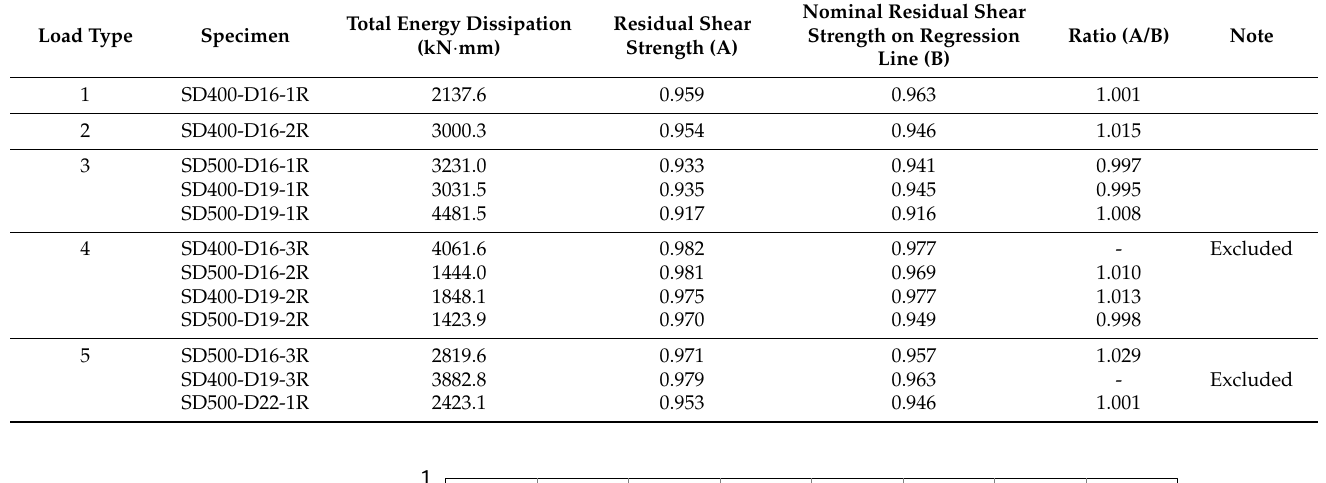
Table 20. Comparison of dissipated energy and residual shear strength.